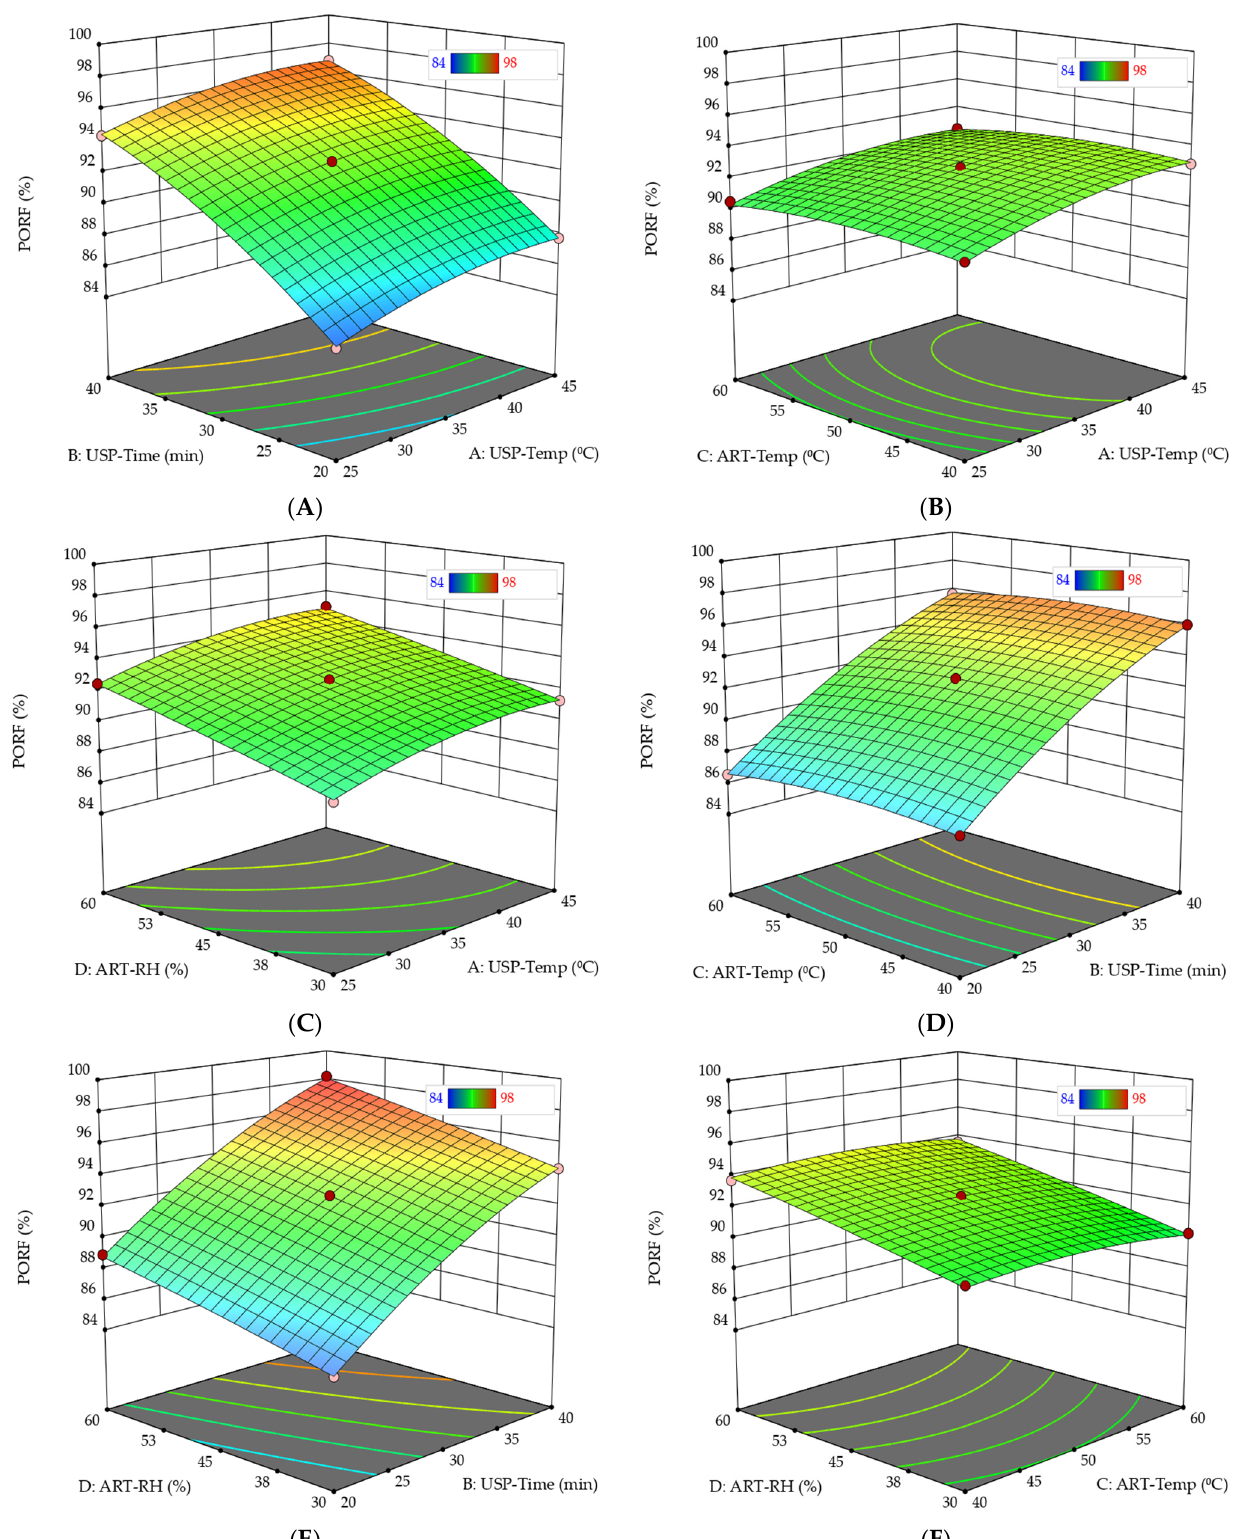
Figure 9. 3D response surface plots representing the effect of A: USP-Temp (ultrasound pretreatment time) and B: USP-Time (ultrasound pretreatment temperature) ( A ), A: USP-Temp and C: ART-Temp (ripening treatment temperature) ( B ), A: USP-Temp and D: ART-RH (ripening treatment RH) ( C ), B: USP-Time and C: ART-Temp ( D ), B: USP-Temp and D: ART-RH ( E ), C: ART-Temp and D: ART-RH ( F ) on the percentage of ripe fruits (PORF).